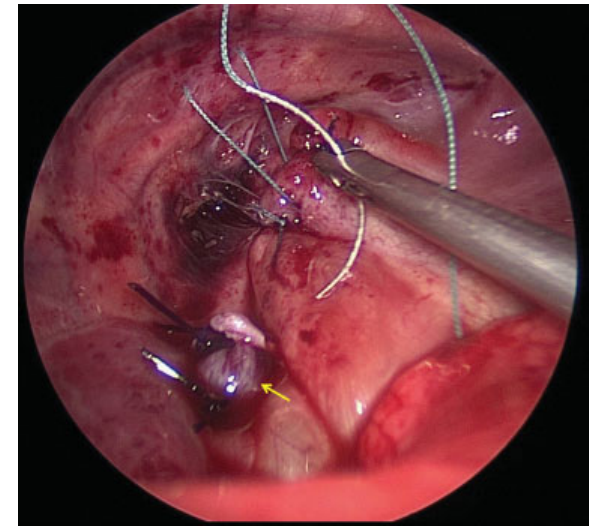
Fig. 3 Diaphragmatic defect repair with interrupted suture. The aberrant vessel has been ligated with two endoloops (arrow).